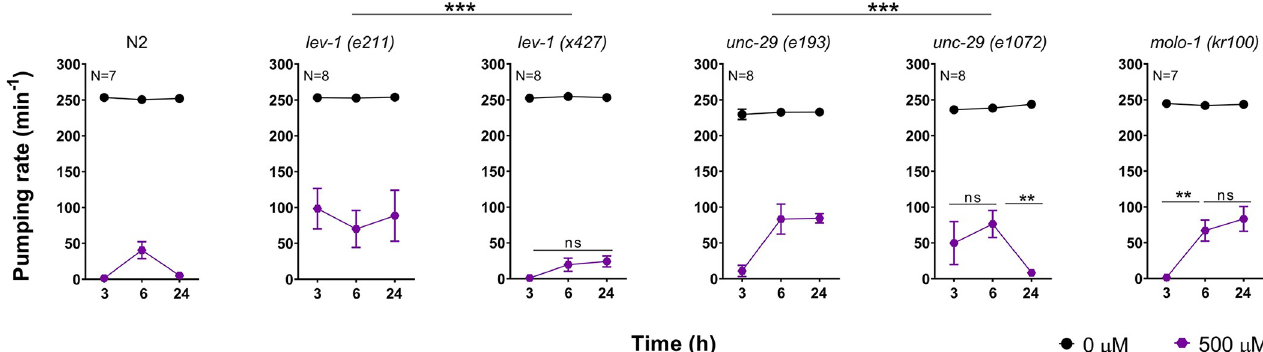
Fig 8. The efficacy of the L-type receptor is a significant determinant of the spontaneous recovery of pharyngeal pumping in nematodes exposed to paraoxon-ethyl. Paraoxon-induced pharyngeal plasticity in wild type nematodes incubated with 500 μ M organophosphate. Data are shown as mean ± SEM of 14 worms in at least 7 independent experiments (N = 14). lev-1 (e211) mutant strain contains a single point mutation in the fourth transmembrane domain. This confers resistance to paraoxon-ethyl induced inhibition of the pharyngeal pumping. Data are shown as mean ± SEM of 8 worms in at least 4 independent experiments (N = 8). The mutation of lev-1 (x427) strain consists of a rearrangement of the genomic sequence that prevents the transcription of the gene into a protein [49]. This is the reference null-mutant of LEV-1. This mutation does not phenocopy the pharyngeal response to paraoxon-ethyl observed in lev-1 (e211) mutant background. Data are mean ± SEM of 8 worms in at least 4 independent experiments (N = 8). The mutation of unc-29 (e193) strain consists of a single point proline to serine in the loop connecting the second and third transmembrane domain of the subunit. This proline is highly conserved in the cys- loop receptor subunits and is implicated with the gating of the receptor [50–52].This mutation conferred a sustained paraoxon-ethyl induced plasticity. Data are shown as mean ± SEM of 8 worms in at least 4 independent experiments (N = 8). In contrast, the null-mutant unc-29 (e1072) exhibited resistance to the pharyngeal inhibition by paraoxon-ethyl but did not express paraoxon-ethyl induced plasticity. Data are shown as mean ± SEM of 8 worms in at least 4 independent experiments (N = 8). MOLO-1 is an auxiliary protein implicated in the positive modulation of the L-type receptor [24]. molo-1 lacking worms exposed to paraoxon-ethyl exhibited spontaneous recovery of the pharyngeal function that was sustained compared to wild type worms. Data are shown as mean ± SEM of 7 worms in at least 4 independent experiments (N = 7). Statistical significance was calculated by two-way ANOVA test followed by Bonferroni corrections. *** p �